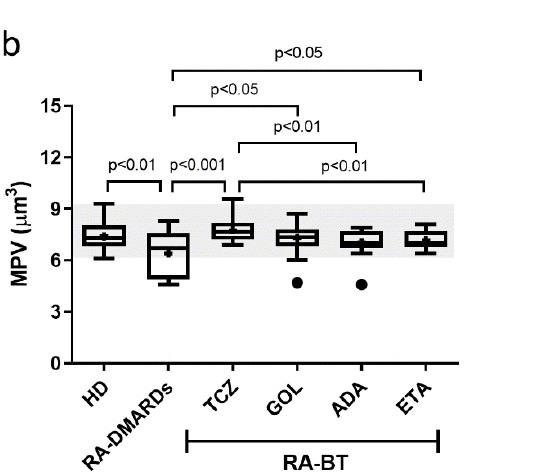
Figure 3: The number of platelets and values of mean platelet volume and platelet diameter width in healthy donors (control), and RA patients un- different types of biological treatment